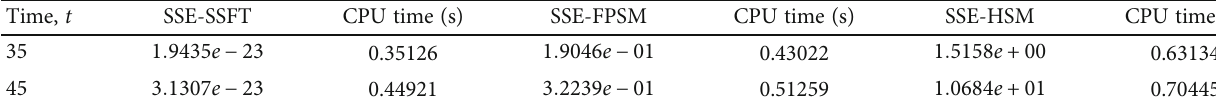
Table 3: A comparison among the sum of squares error (SSE) of the split-step Fourier transform (SSFT), the Fourier pseudospectral method (FPSM), and the Hopscotch scheme (HSM), computed for di ff erent time values t from 35 to 105 : When h = 0 : 2 and τ = 0 : 008 . Time, t